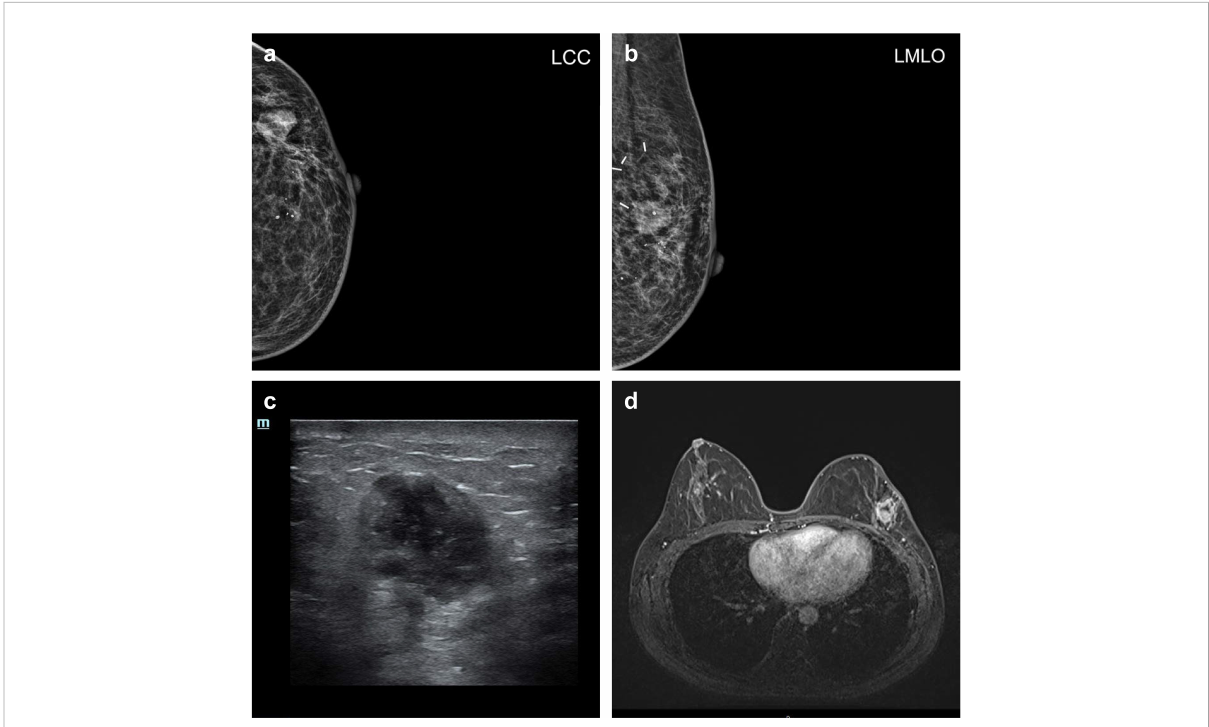
FIGURE 1 Radiology. (A) Left craniocaudal (LCC) view and (B) left mediolateral oblique (LMLO) view of mammography. (C) Representative ultrasound imaging of a breast lesion. (D) Representative MRI imaging of a breast